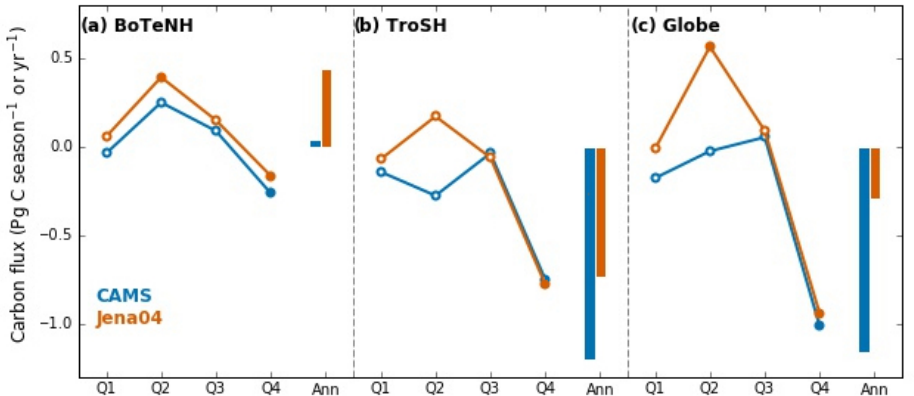
Figure 5. Seasonal land carbon-uptake anomalies in 2015. Data are linearly detrended for 1981–2015 for different seasons in 2015, by CAMS (blue) and Jena04 (orange) inversion data. Open or solid dots indicate seasonal values (Pg C season − 1 ) and vertical bars indicate annual sums (Pg Cyr − 1 ) . Data are shown for: (a) boreal and temperate Northern Hemisphere (BoTeNH, >23.5 ◦ N), (b) tropics and extratropical Southern Hemisphere (TroSH, <23.5 ◦ N) and (c) the whole globe. Solid dots indicate seasonal land carbon-uptake anomalies below the 10th or above the 90th percentiles for 1981-2015.